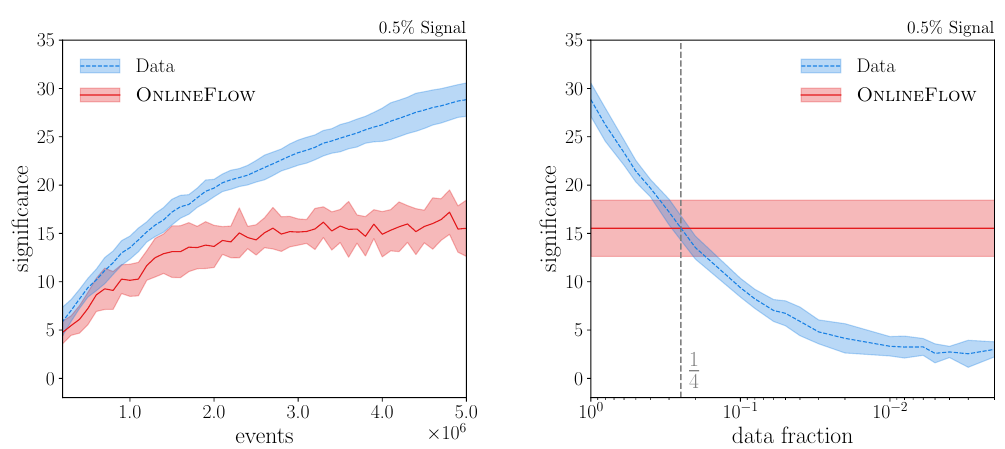
Figure 6: Left: signal significance as a function of the amount of training data for the classical approach, based on all training data, and the O NLINE F LOW . Right: signal significance as a function of the prescale factor. A prescale factor of one corresponds to 500 × 10 4 events. The shaded regions estimate the uncertainty based on five executions of the experimental setup. The dotted grey line indicates the crossover point at a datafaction of 1 , which corresponds to a prescale factor of 4